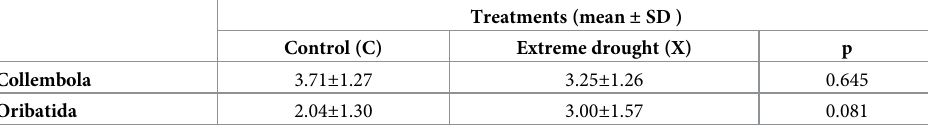
Table 2. Species richness of Collembola and